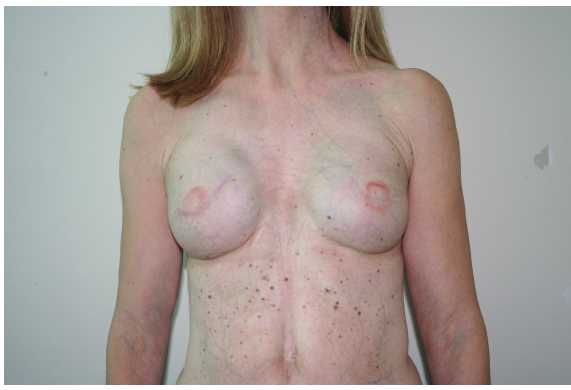
Figure 6: Postoperative view 18 months after one sugical stage mammary reconstruction and a bilateral areola-tattoo.